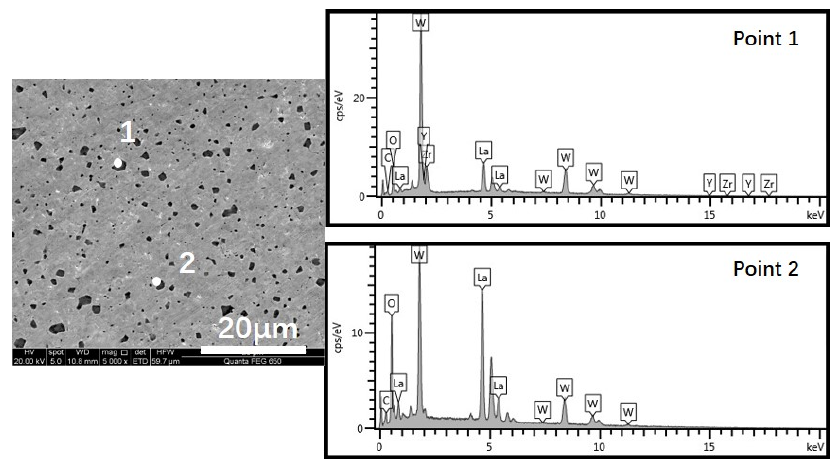
Figure 5. SEM and EDS images of the sample doped with 0.05% ZrH 2.